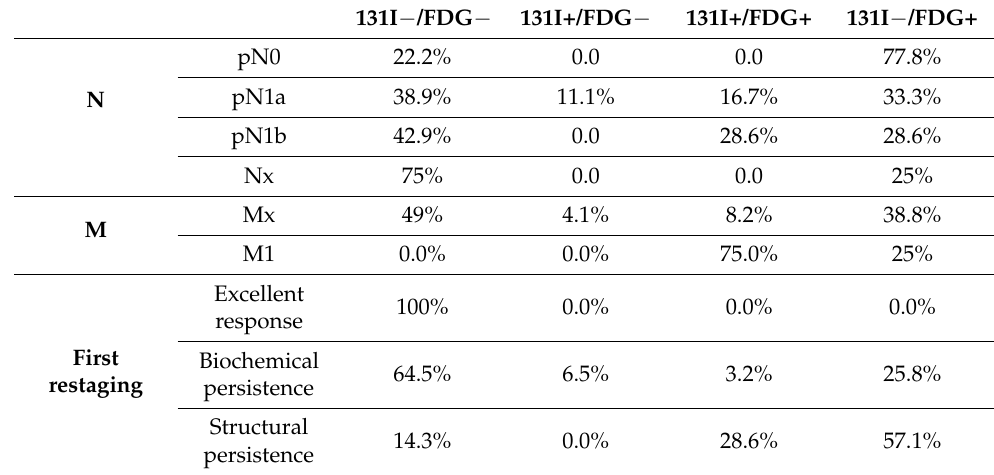
Table 6. Association between 131I/FDG findings and N, M, and first restaging data.